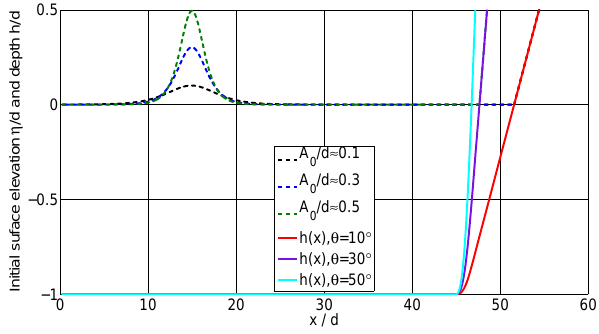
Fig. 2. Examples of the model setup, for three different initial wave configurations and bathymetric slopes,